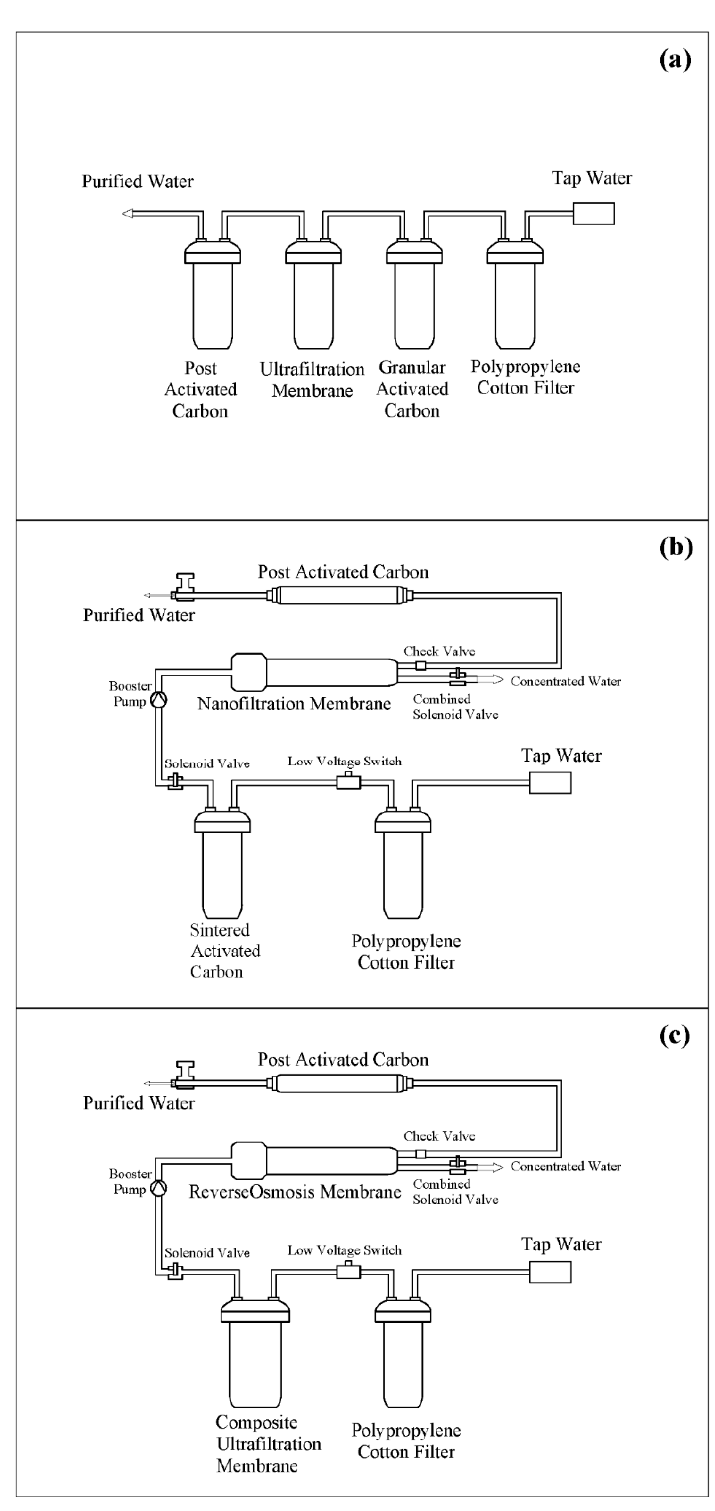
Figure 2. Domestic water purifier process flow chart: ( a ) ultrafiltration, ( b ) nanofiltration and ( c ) reverse osmosis.